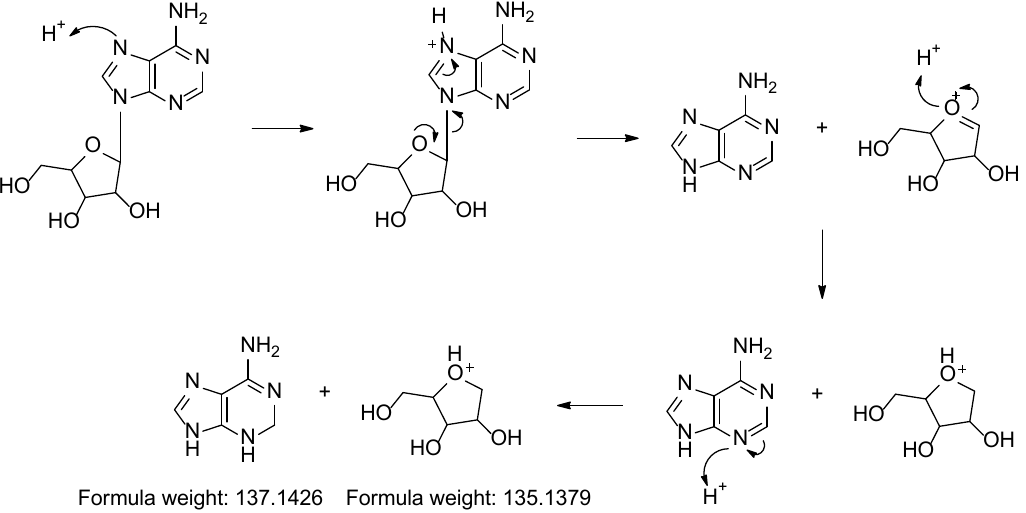
under acidic condition with H + ion acting as a protonating agent [8,30,31]. 2